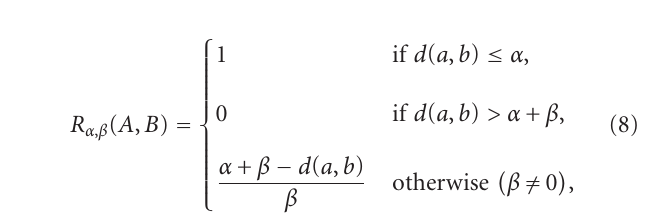
Top. Rel. = Equal Dir. =